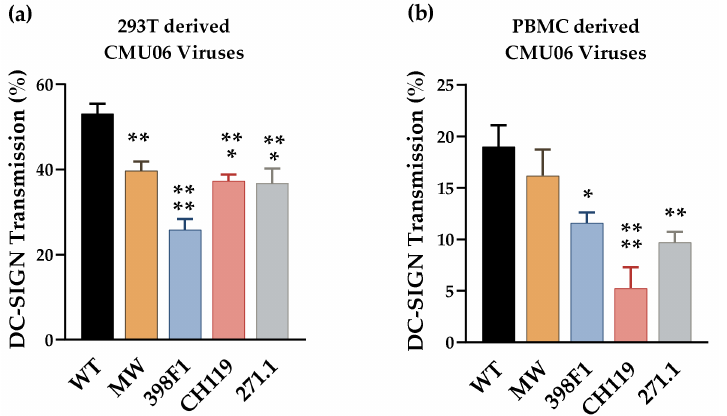
Figure 8. DC-SIGN mediated HIV-1 transmission. Raji–DC-SIGN+ cells were incubated for 2 h with WT or SP swapped viruses produced in ( a ) HEK293T and ( b ) human peripheral blood mononuclear cells (PBMC). Cells were washed to remove unbound viruses and added to CD4+ TZM.bl cells. Viral transmission to the TZM-bl cells was determined by luciferase activity and calculated based on infection in TZM.bl cells without Raji cells as control (set to 100%). Background luciferase activity was determined in co-cultures without any virus. *, p < 0.05; **, p < 0.01; ***, p < 0.001; ****, p < 0.0001 vs. by